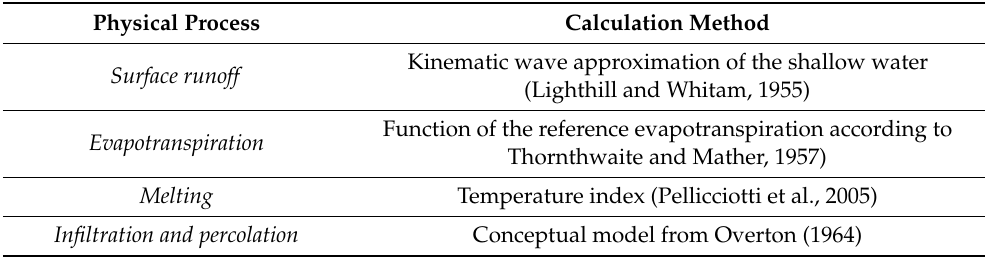
Table 1. Main hydrological processes parameterized in the CHyM model and their references. Physical